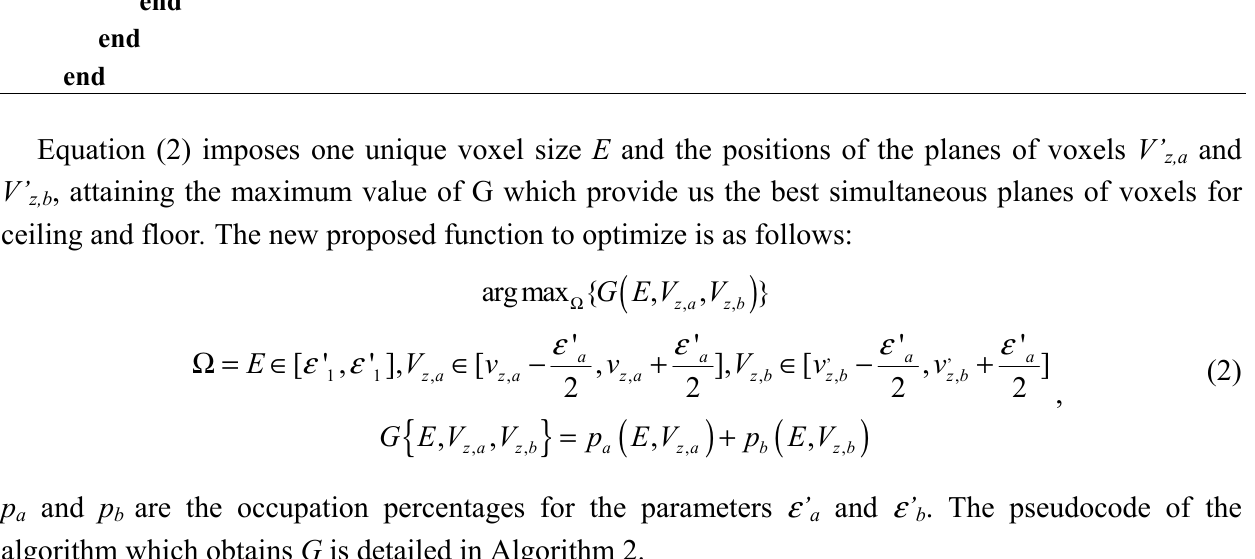
Algorithm 1. Calculation of optimum values ε ’ and v’